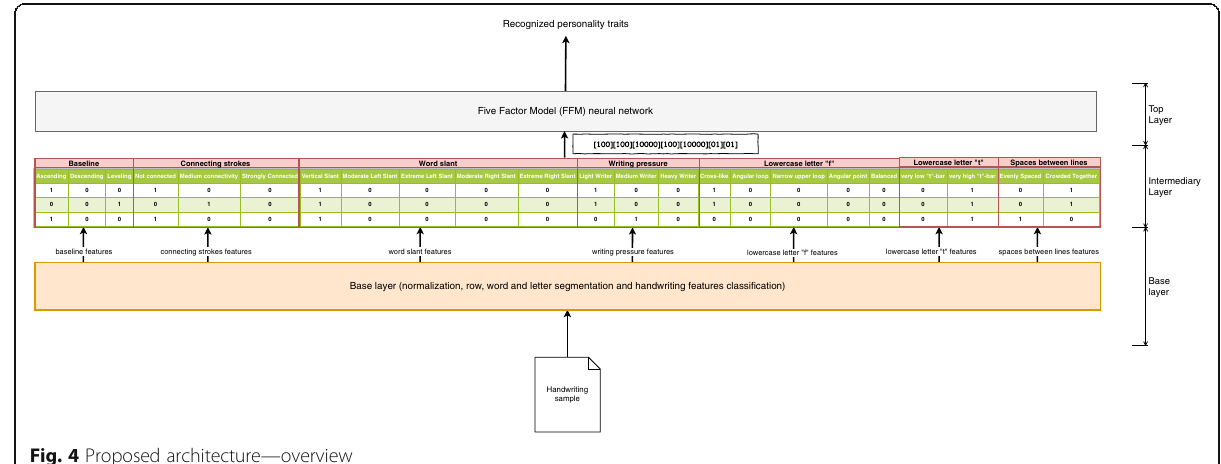
Fig. 4 Proposed architecture —